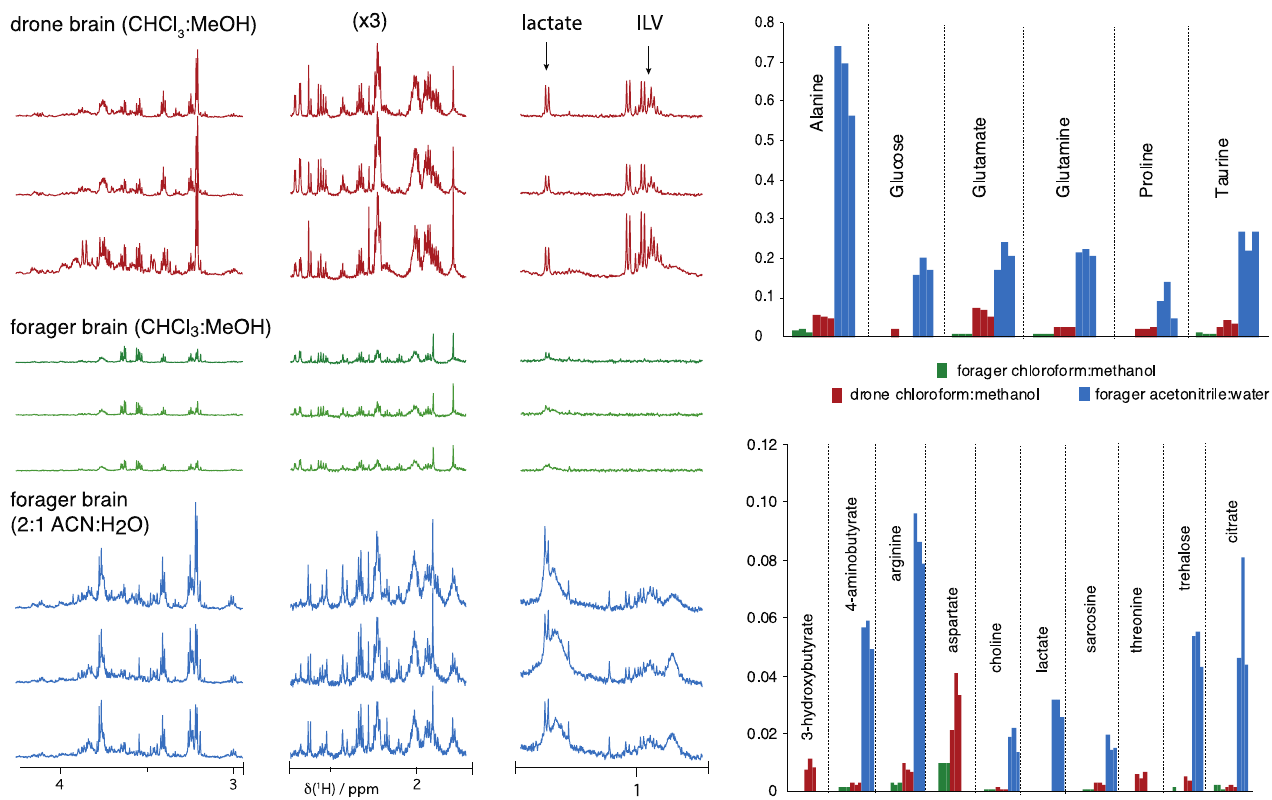
Figure 5. 1 H-NMR spectra (600 MHz, pr-NOESY, RT inverse probe) of aqueous metabolites extracted from dissected bee brains using both chloroform:methanol and acetonitrile:H 2 O (2:1) in both drones and foragers. For comparison, all spectra employed 128 scans and dissections preserved optic material (i.e., eyes). Note overall higher recovery of metabolites in the ACN:water extracts, where several amino acids (particularly ILV) are observed only in the ACN:water extracts.